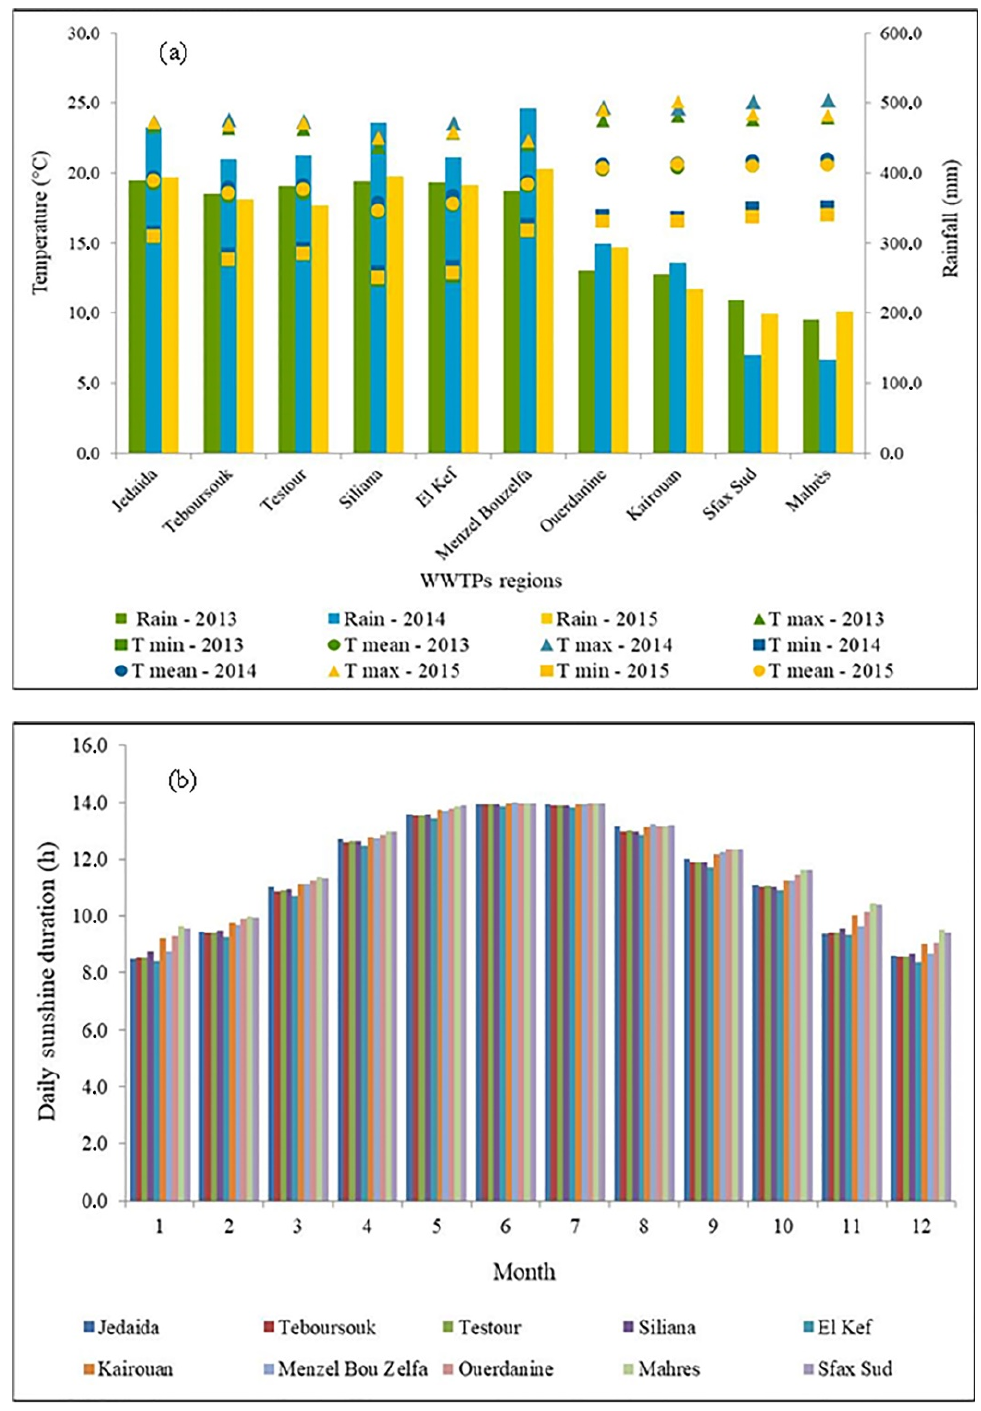
Figure 2. ( a ) Mean temperature, annual rainfall, and ( b ) sunshine duration distribution at the ten WWTPs during the study period (2013 – 2015). WWTPs during the study period